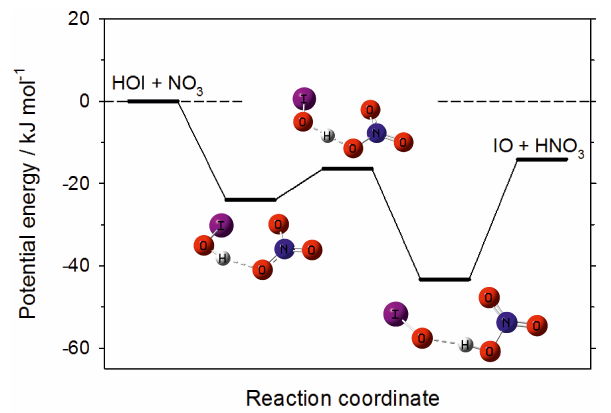
Figure 3. Potential energy surface for the reaction between HOI and NO 3 , which contains two intermediate complexes separated by a submerged